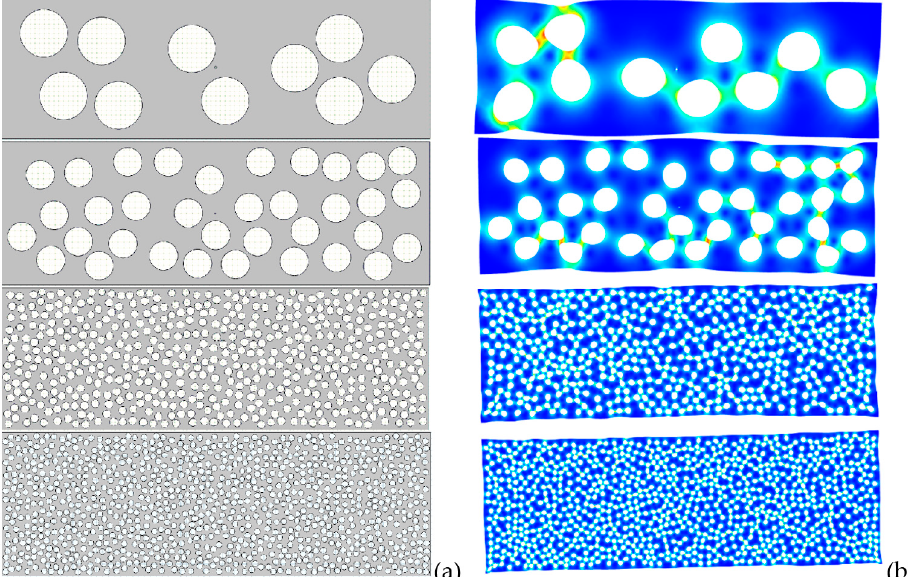
Figure 5. Systems with 10, 50, 500 and 950 circular inclusions ( a ) and the corresponding simulated microstructures after the deformation by isostatic pressing ( b ).